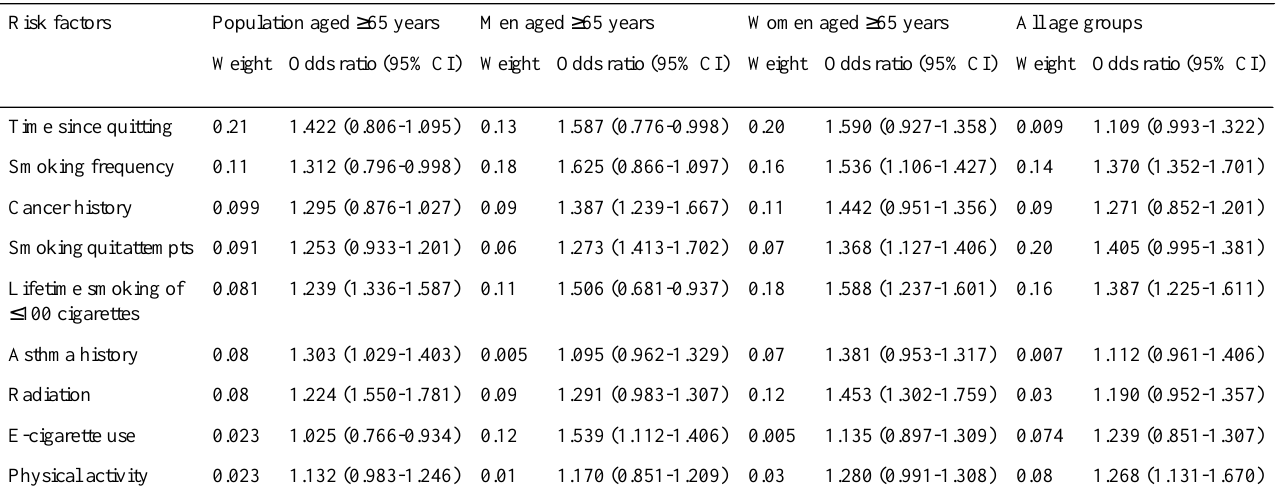
Table 2. Normalized weight values and odds ratios (95% CI) of the main risk factors in the 4 population